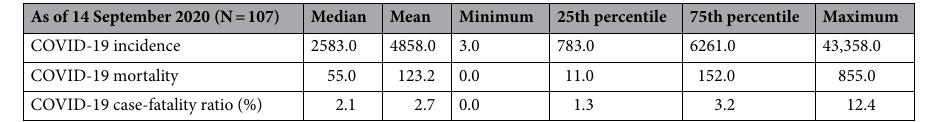
Table 3. COVID-19 health-related outcomes of total selected countries. COVID-19 incidence total confirmed cases of COVID-19 per one million population, COVID-19 mortality deaths due to COVID-19 per one million